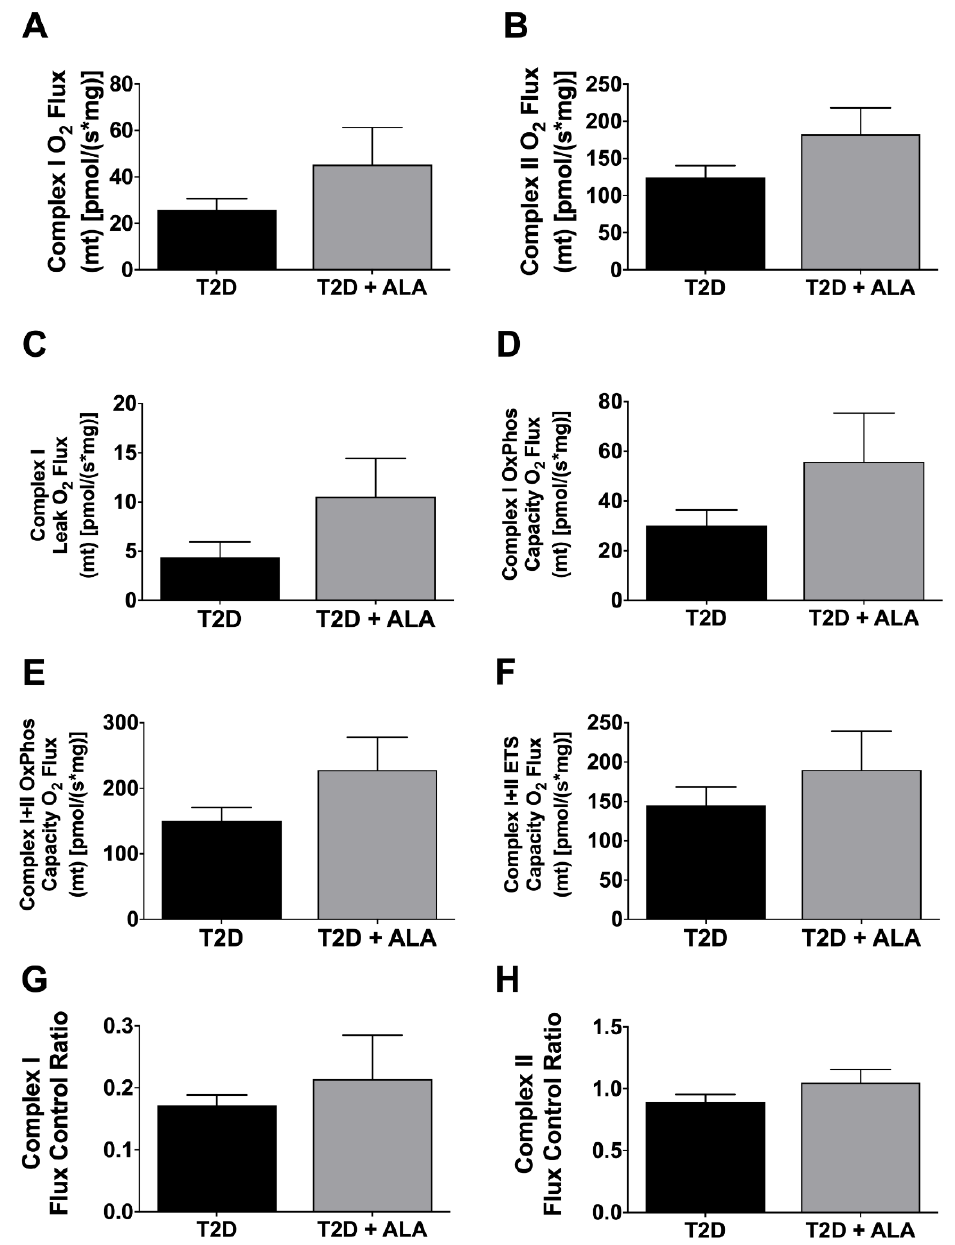
Figure 6. Mitochondrial respiratory function in ventricular myocardium from T2D mice ± dietary ALA supplementation. Data shown for ( A ) Complex I O 2 Flux; ( B ) Complex II O 2 Flux; ( C ) Complex I Leak O 2 Flux; ( D ) Complex I oxidative phosphorylation (OxPhos) Capacity O 2 Flux; ( E ) Complex I+II OxPhos Capacity O 2 Flux; ( F ) Complex I+II electron transfer system (ETS) Capacity O 2 Flux; ( G ) Complex I Flux Control Ratio; and ( H ) Complex II Flux Control Ratio. Results shown as means ± SEM ( n = 6 / group). No significant effects of ALA supplementation were detected.